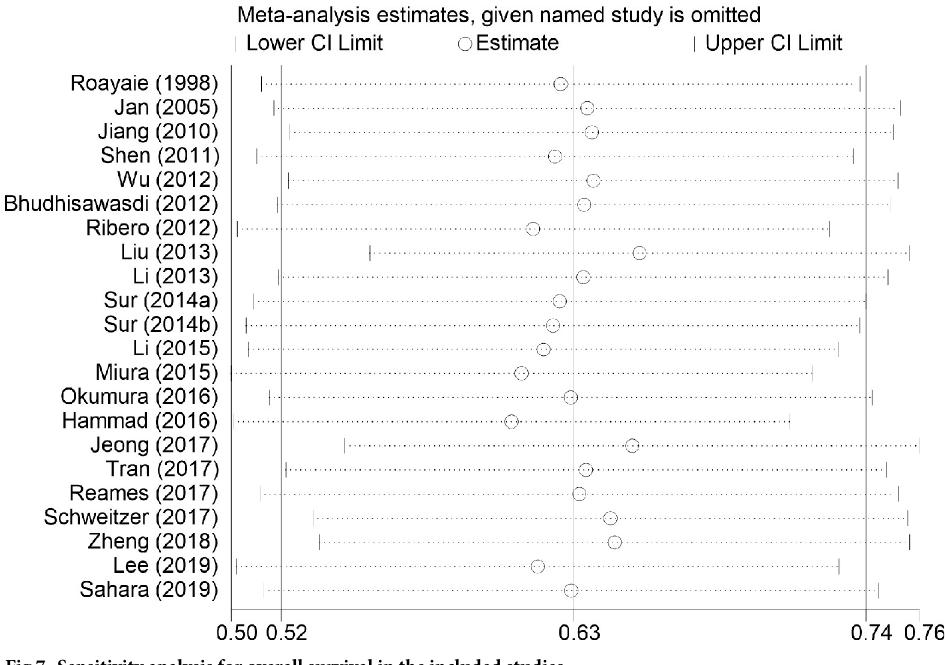
Fig 7. Sensitivity analysis for overall survival in the included studies.